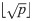
Trees’ preference for predicting larger class in dependence on mtry and number of predictors.Fraction of class 1 (minority class in training sample) predictions obtained for balanced test samples with 5000 observations from class 1 and 2, each (null case setting). Predictions were obtained by RFs with specific mtry from a corresponding grid of mtry values ({1, 2, …, 10} for p = 10, {1, 10, 20, …, 100} for p = 100, {1, 100, 200, …, 1000} for p = 1000). RFs were trained on n = 30 observations (10 from class 1 and 20 from class 2) with p ∈ {10, 100, 1000}. The mean fractions over 500 repetitions are shown. The grey dots indicate the most commonly used default choices for mtry in classification tasks, that is ⌊p⌋.